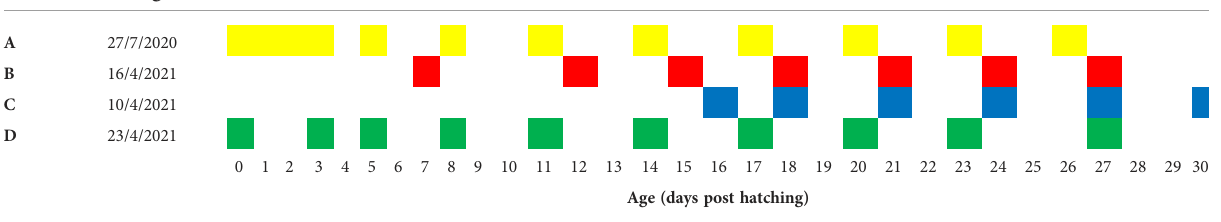
TABLE 1 Hatching date and sampling points of grey mullet larvae